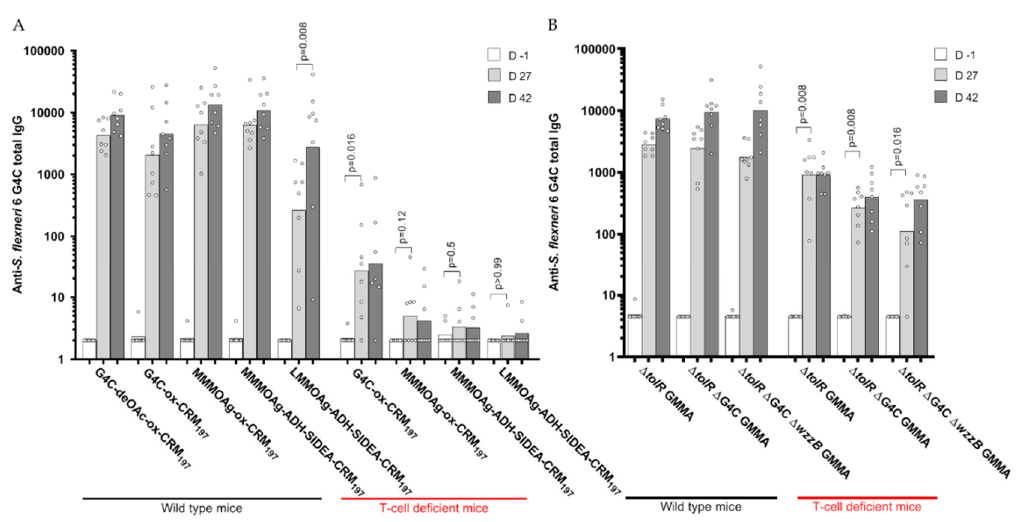
Figure 5. Immunogenicity of S. flexneri 6 glycoconjugates ( A ) and GMMA ( B ) differing in sugar length compared in mice. Eight wild-type and T-cell deficient mice per group were subcutaneously immunized at days 0 and 28, with 1 µ g OAg dose on Alhydrogel (glycoconjugates) or 0.5 µ g OAg dose without Alhydrogel (GMMA). Summary graphs of anti-OAg specific IgG geometric mean units (bars) and individual antibody levels (dots).